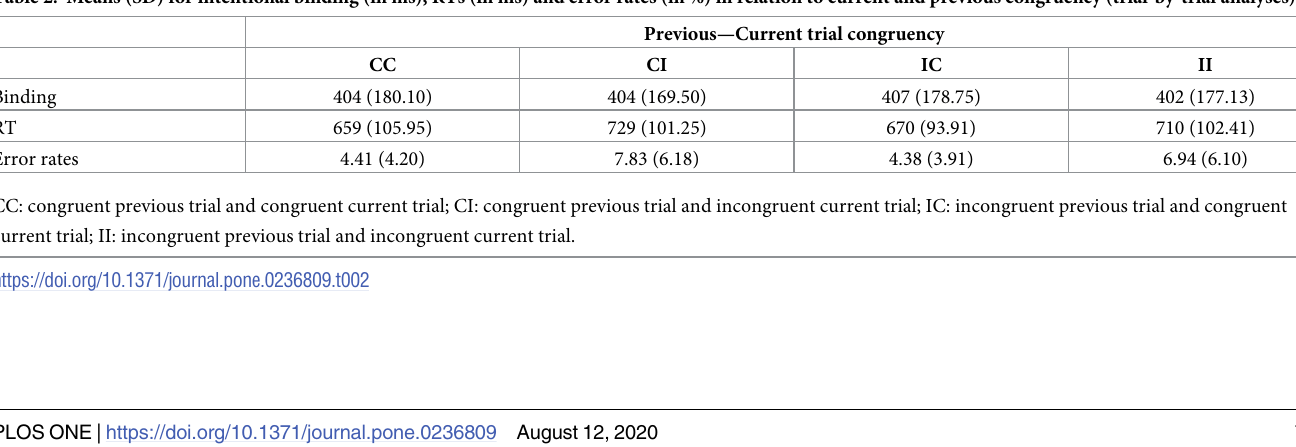
Table 2. Means (SD) for intentional binding (in ms), RTs (in ms) and error rates (in %) in relation to current and previous congruency (trial-by-trial